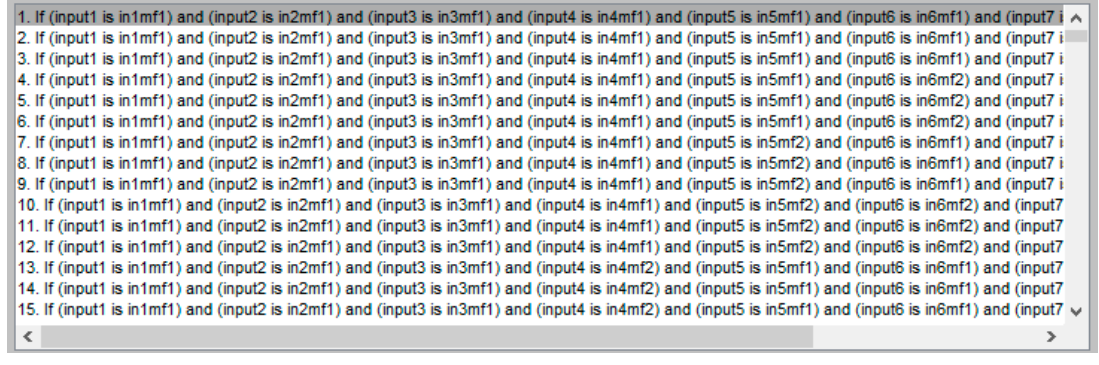
Figure 13. Rules in ANFIS for renal cancer.